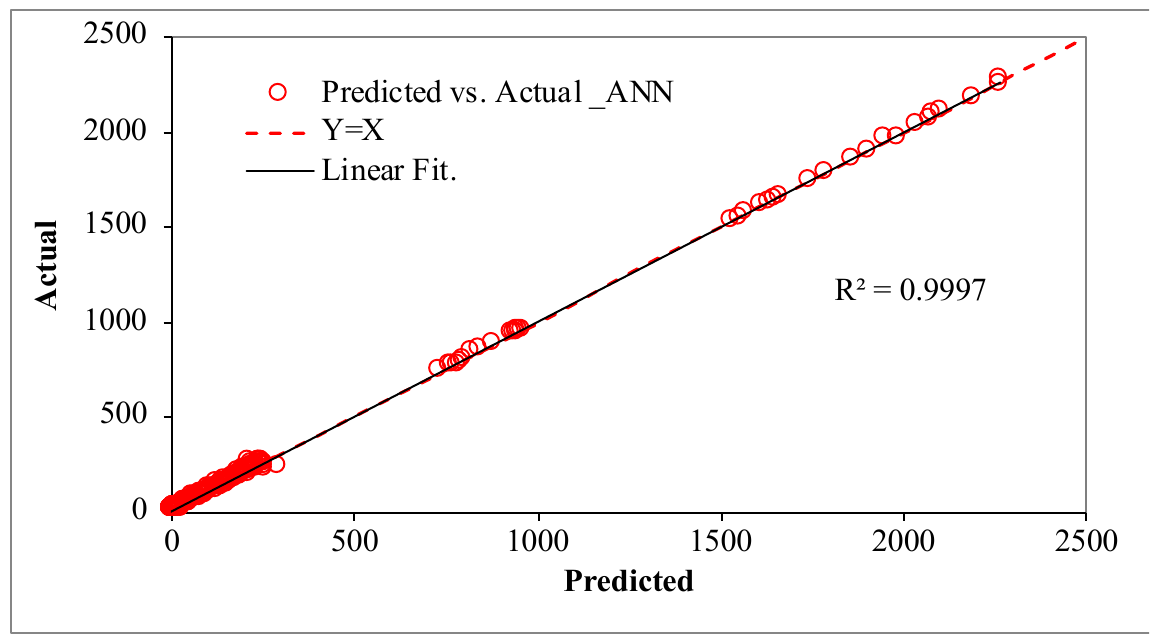
Figure 4. Predicted vs. actual annual road accident plot for ANN model.